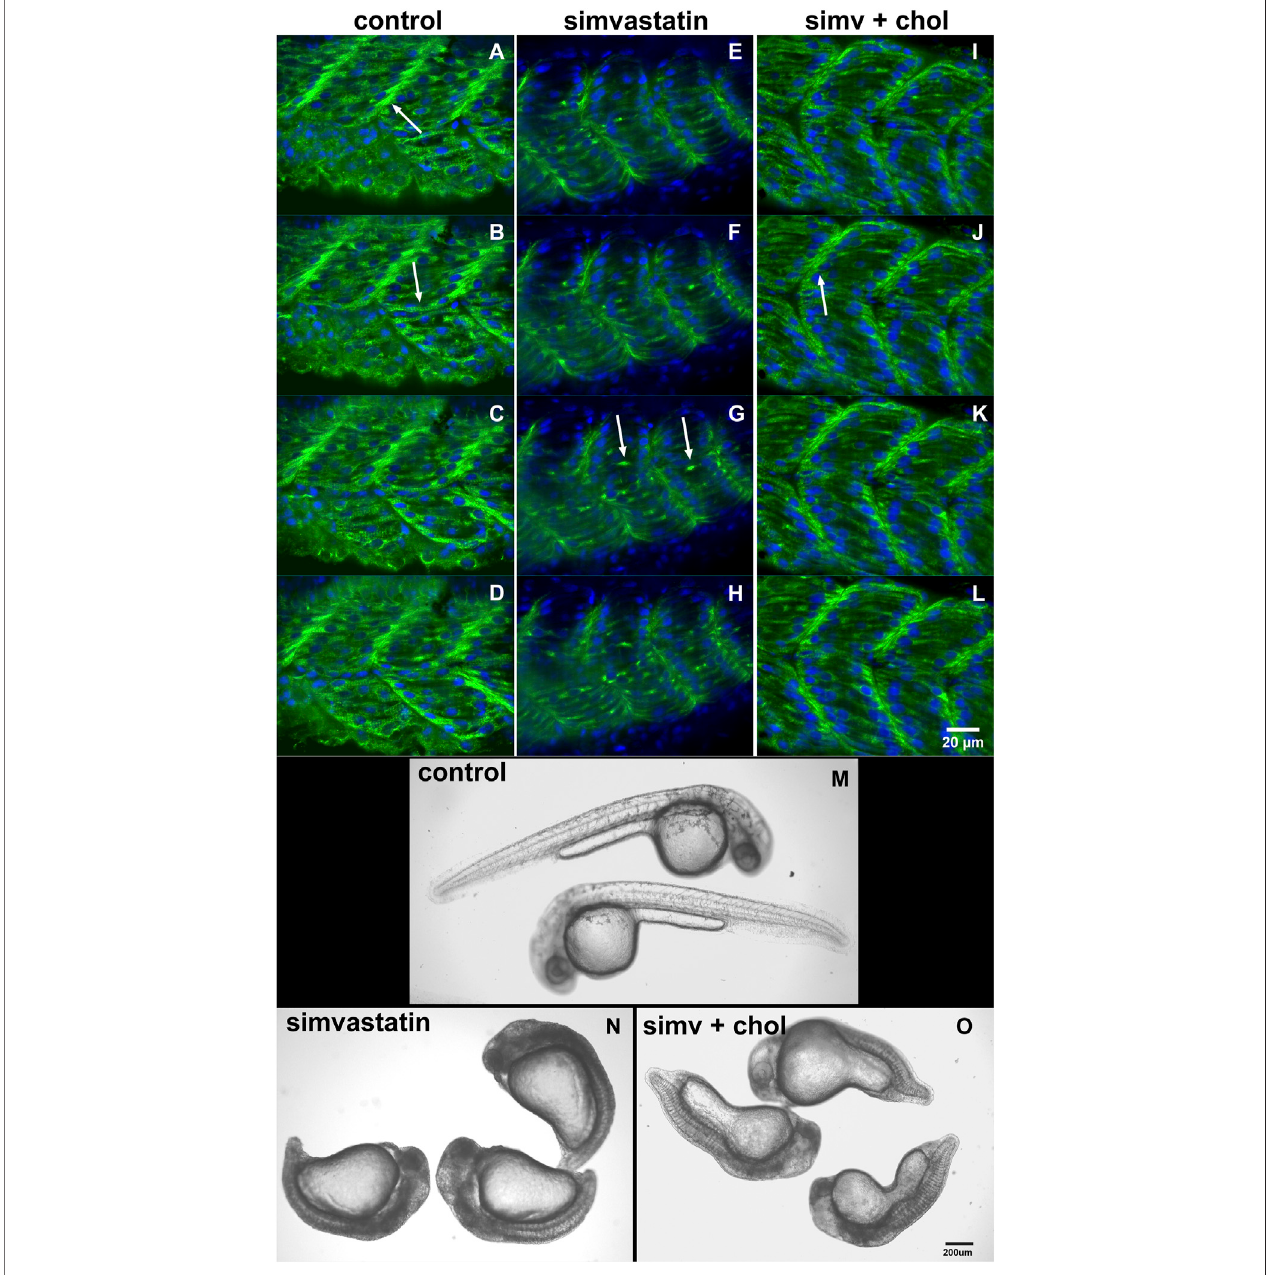
FIGURE 1 | Cholesterol rescues the simvastatin-affected phenotype. The distribution ofdesmin (green) and nuclei (blue) in four consecutivefocal planes ofcontrol (A – D) , 0.3 nM (low-dose) simvastatin-treated 48 hpf embryos (E – H) , and simvastatin combined with cholesterol (I – L) show that simvastatin causes important alterations that are rescued with cholesterol. Note that in control [non treated embryos, (A – D) ] and in embryos treated with simvastatin together with cholesterol (I – L) , desmin concentrates in the septa between adjacent somites [arrows in (A) and (J) ] and in sarcomeres along the somites [arrow in (B) ]. Conversely, desmin accumulates in aggregates in somites [arrows in (G) ]in simvastatin treated embryos (E – H) . Inembryostreatedwith 0.75 μ Msimvastatin (high-dose), an important body compressionisobserved (N) ,while24 hpfcontrolembryoshavealongstraightbody (M) .Notethattheadditionofexogenouscholesterolcanpartiallyrescuetheeffects of simvastatin on body compression (O) . Scale bars: (A – L) = 20 μ m, (M – O) = 200 μ m.